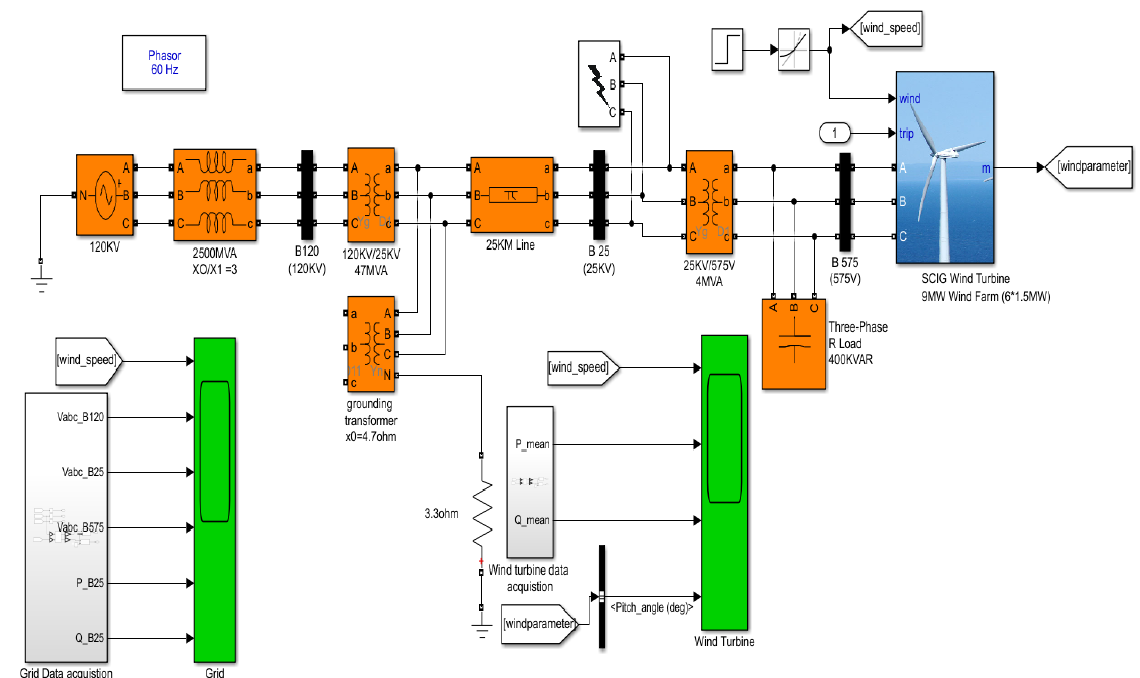
Figure 4. Simulink model of SCIG wind turbine connected to a grid network .